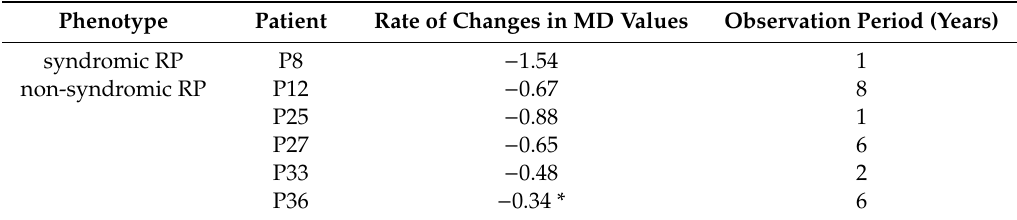
Table 5. Rate of changes in MD values of USH2A -RP